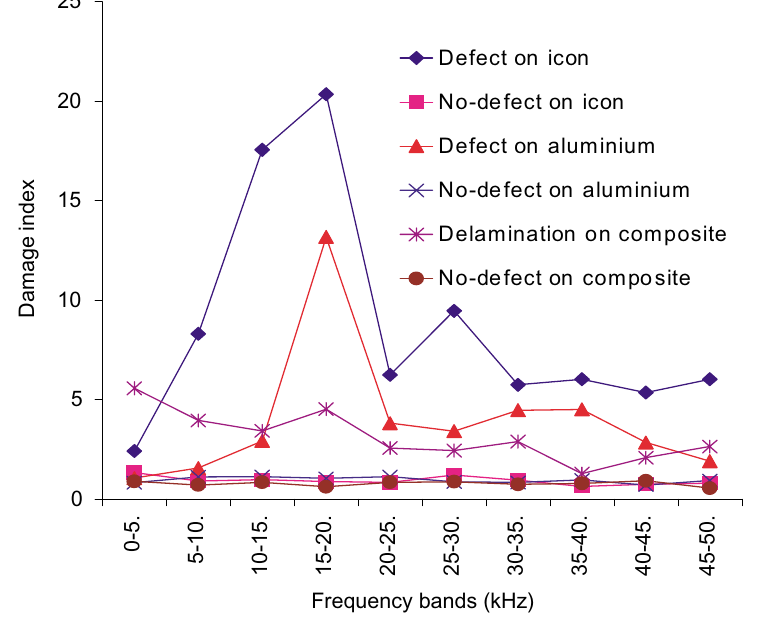
Fig. 21. Comparison between Damage Index for different